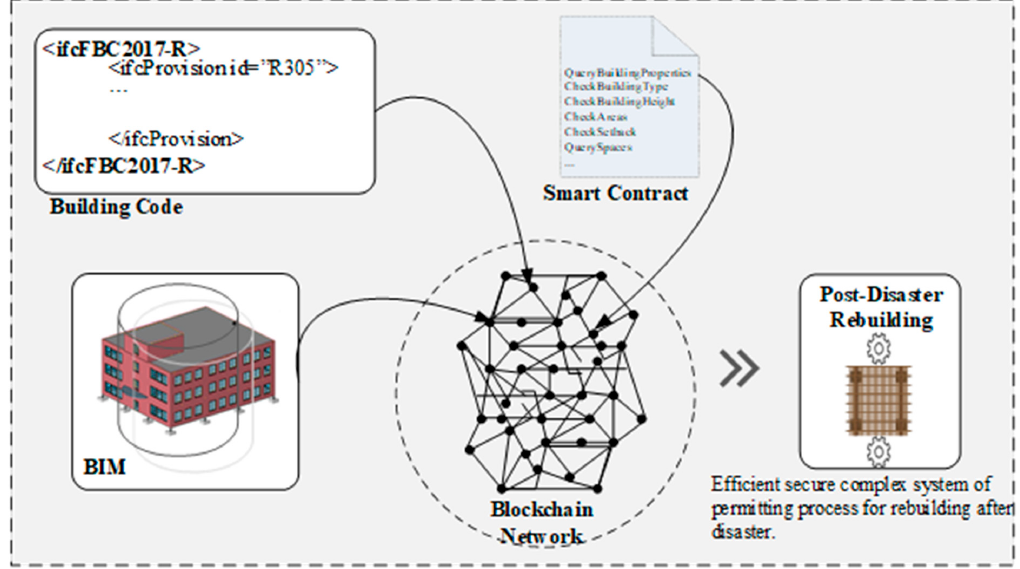
Figure 5. Integrative BCT + BIM Framework for Virtual Permitting.